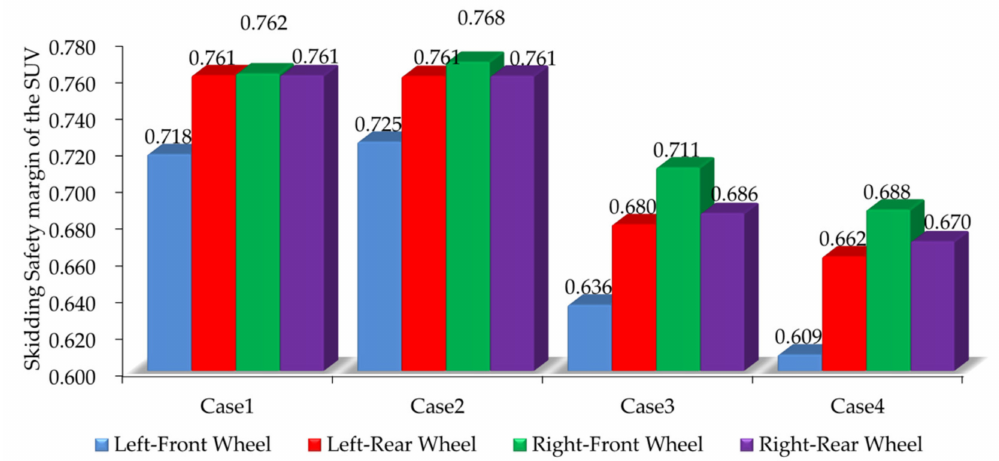
Figure 5. Skidding safety margins of four wheels under di ff erent road